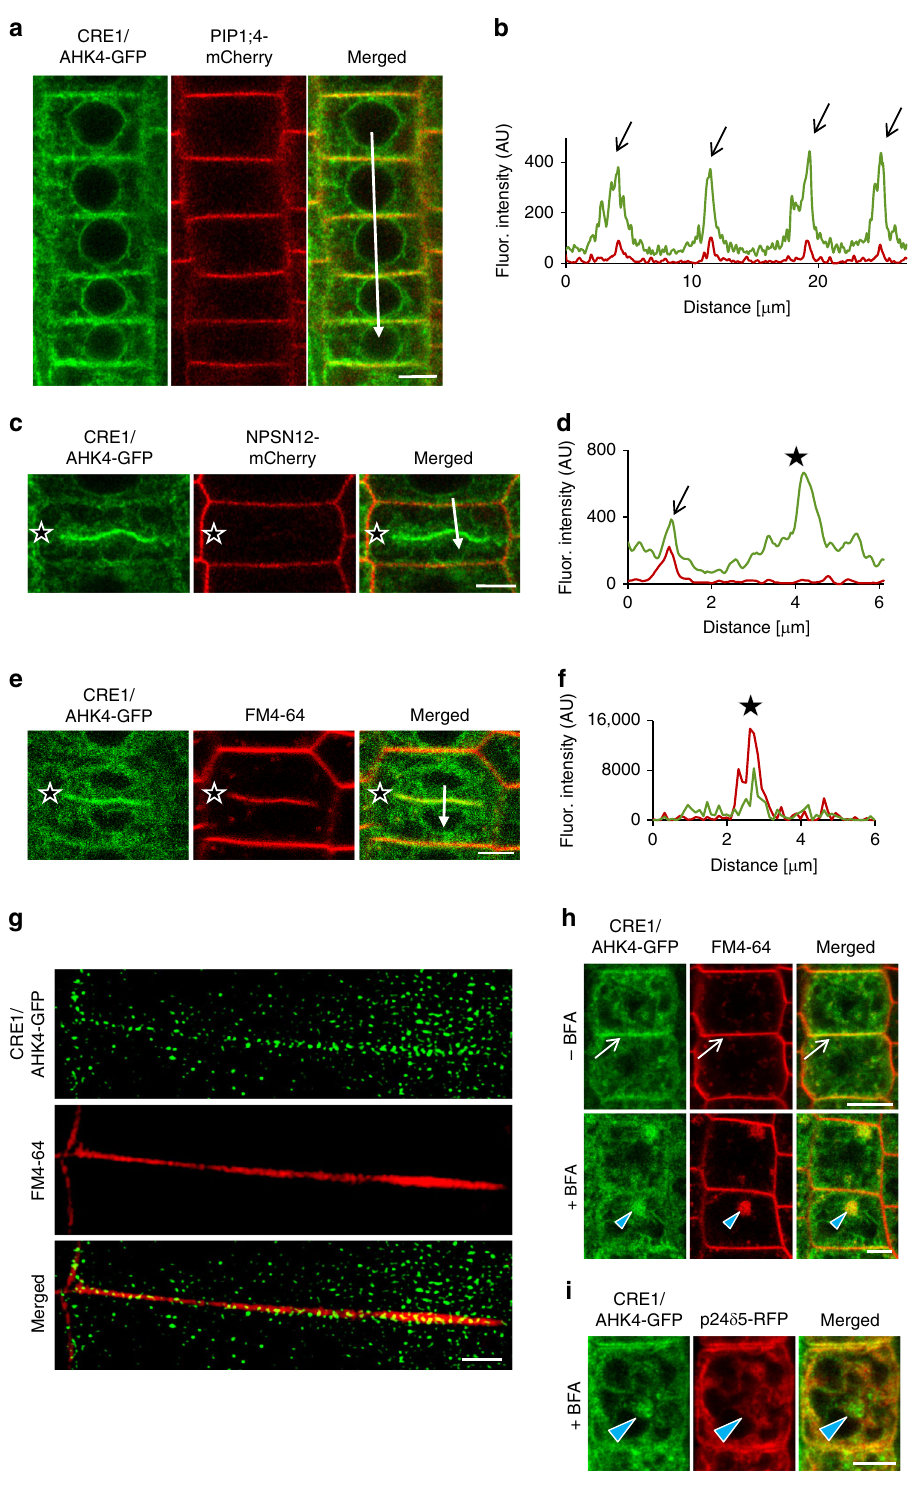
Fig. 4 CRE1/AHK4-GFP co-localization with the plasma membrane markers in Arabidopsis root cells. a – f Co-localization of CRE1/AHK4-GFP with the plasma membrane markers PIP1;4-mCherry ( a , b ), NPSN12-mCherry ( c , d ) and FM4-64 ( e , f ) in the root meristematic epidermal cells. Pro fi les of fl uorescence intensity of PM marker (red line) and CRE1/AHK4-GFP (green line) ( b , d , f ) were measured along the white lines ( a , c , e ) starting from the upper end (0 µ m) towards the arrowhead. Peaks of PIP1;4-mCherry and NPSN12-mCherry fl uorescence maxima correlate with the plasma membrane staining and overlap with CRE1/AHK4-GFP signal maxima (black arrows) ( a – d ). CRE1/AHK4-GFP signal detected at the cell plate of dividing cell (black stars on c , e ) co-localizes with FM4-64 marker ( e , f ; black stars) but not with the plasma membrane marker NPSN12-mCherry ( c , d ; black stars). g Super- resolution imaging (SIM) of CRE1/AHK4-GFP subcellular co-localization with FM4-64 labelled PM. h , i Co-localization of CRE1/AHK4-GFP and FM4-64 ( h ), but not p24 δ 5-RFP ( i ) in endosomal compartments (blue arrowheads) formed in root meristematic epidermal cells treated with 50 µ M in BFA for 1 h. Note CRE1/AHK4-GFP localization at the plasma membrane (white arrows) prior BFA treatment. Scale bars = 5 μ m ( a , c , e , h , i ) and 2 μ m ( g